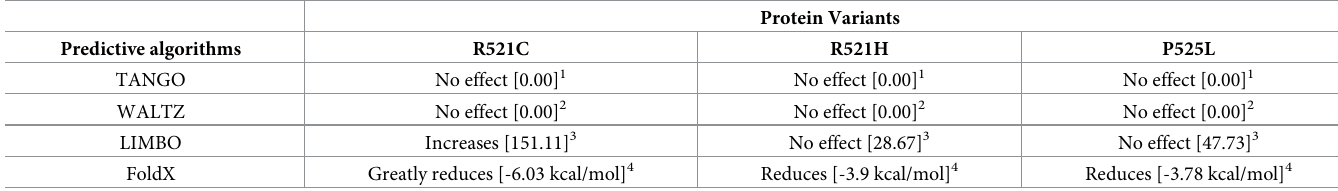
Table 2. SNPeffect and FoldX effect predictions of FUS